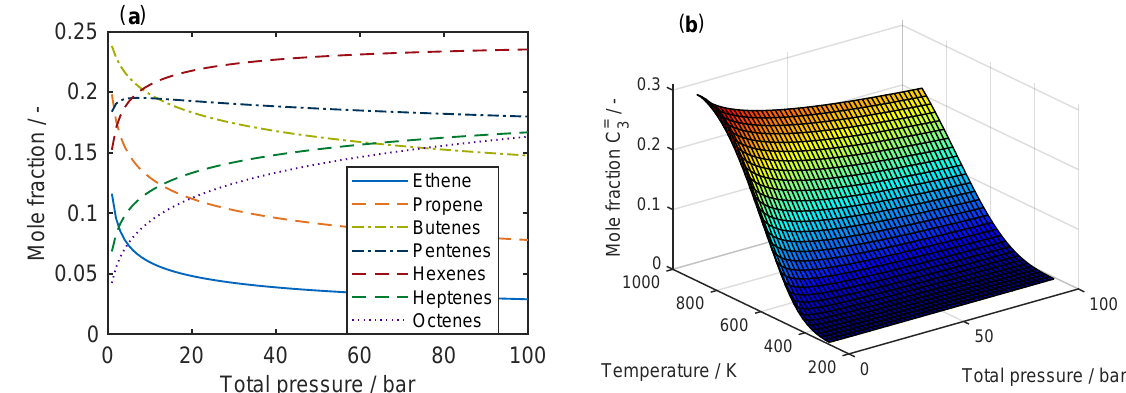
to C = : ( a ) as a function of total pressure at 2 8